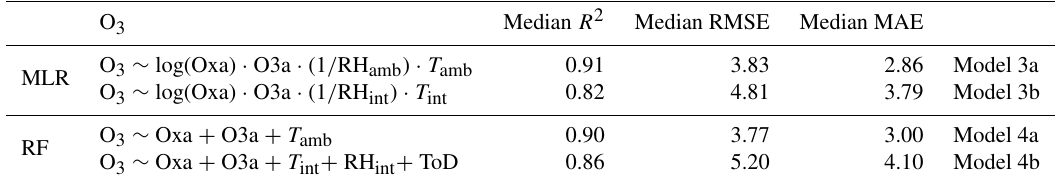
Table 7. Median R 2 and RMSE across all test blocks of the best MLR and RF models using internal and ambient T and RH for O 3 . RMSE and MAE are reported in units of parts per